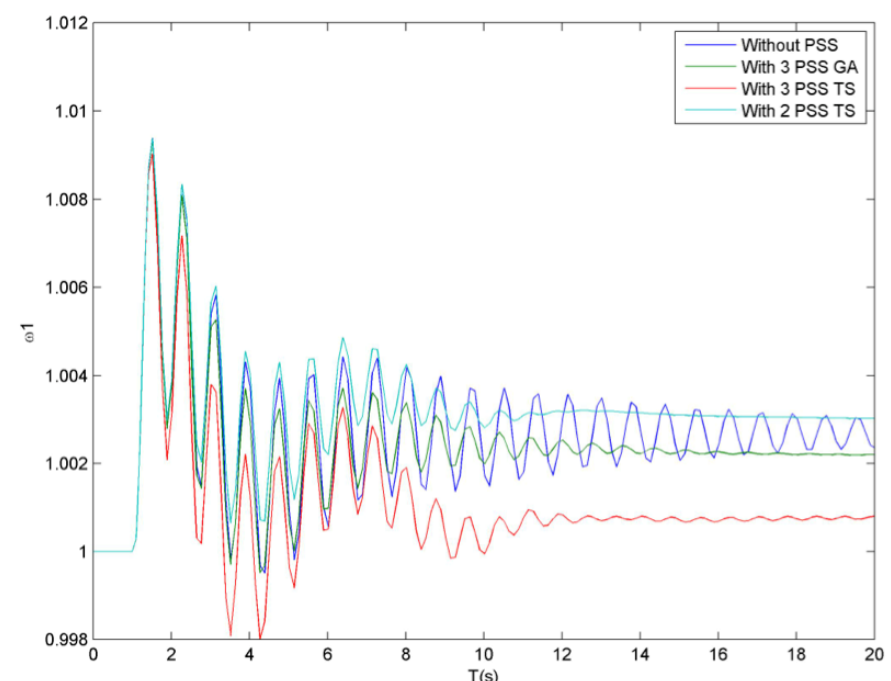
Figure 7. Velocity response of the machine of the three-machine—nine-busbar IEEE system when a fault occurs at busbar 7, considering the different scenarios of the controllers’ parameters. Angular velocity ω 1 is shown in dependence of time T in